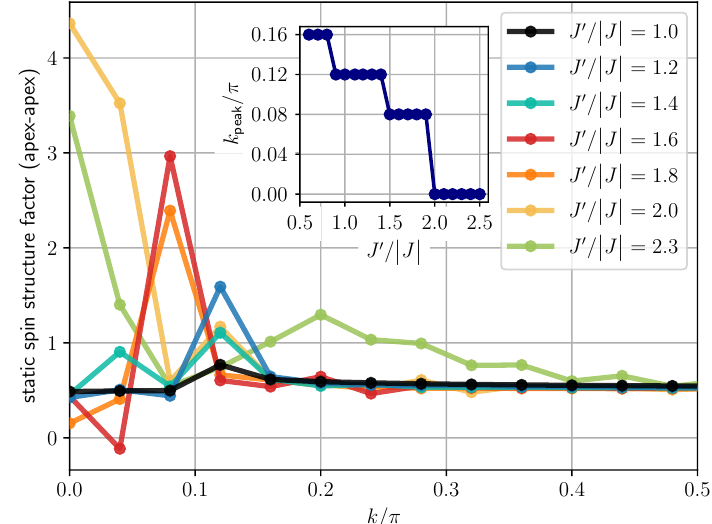
Figure 10: The same as Fig. 8, but for a fixed system size of L = 100 and different (cid:12) (cid:12) values of J ′ / (cid:12) J (cid:12) . The inset shows the position of the main peak as a function of J